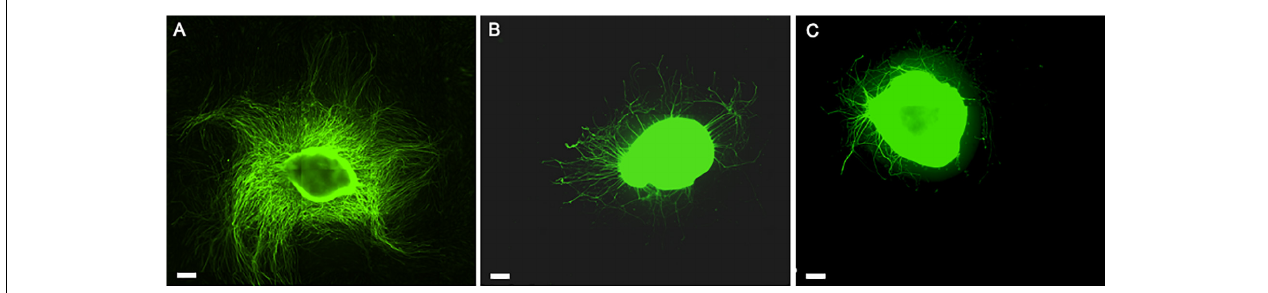
FIGURE 9 | The role of hADSC cell-to-cell interaction and secretome when expanded with the hPL in in vitro DRG co-culture model. Direct co-culture of DRG with hADSC hPL on LN-coated surface (A) , indirect co-culture of DRG with hADSC hPL secretome on LN-coated surface (B) , and DRG alone on LN (C) . Scale bar: 500 µ m.